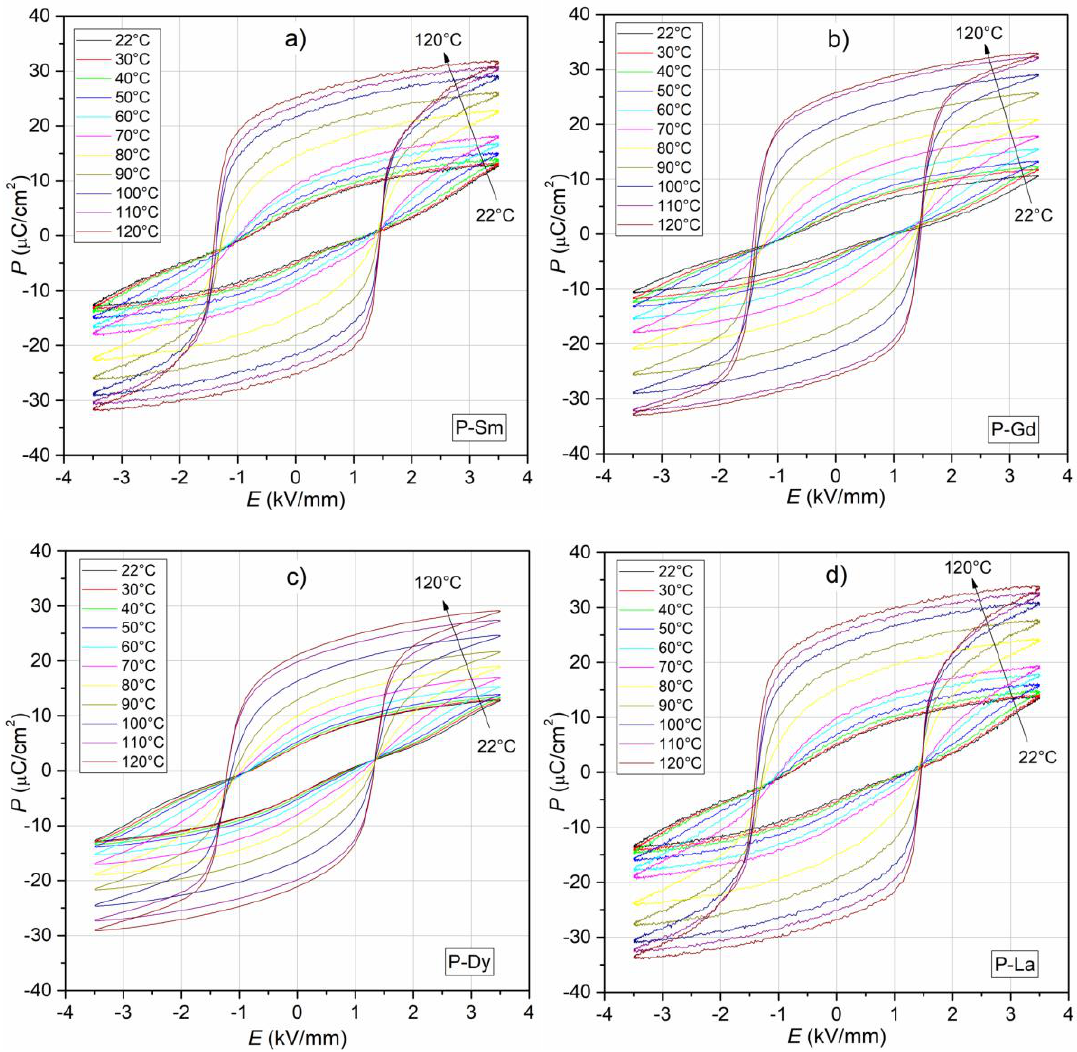
Figure 11. The P-E hysteresis loops for the four multicomponent PZT-type materials (in temperature range from 22 to 120 ◦ C, 1 Hz). : ( a ) P-Sm, ( b ) P-Gd, ( c ) P-Dy, ( d )